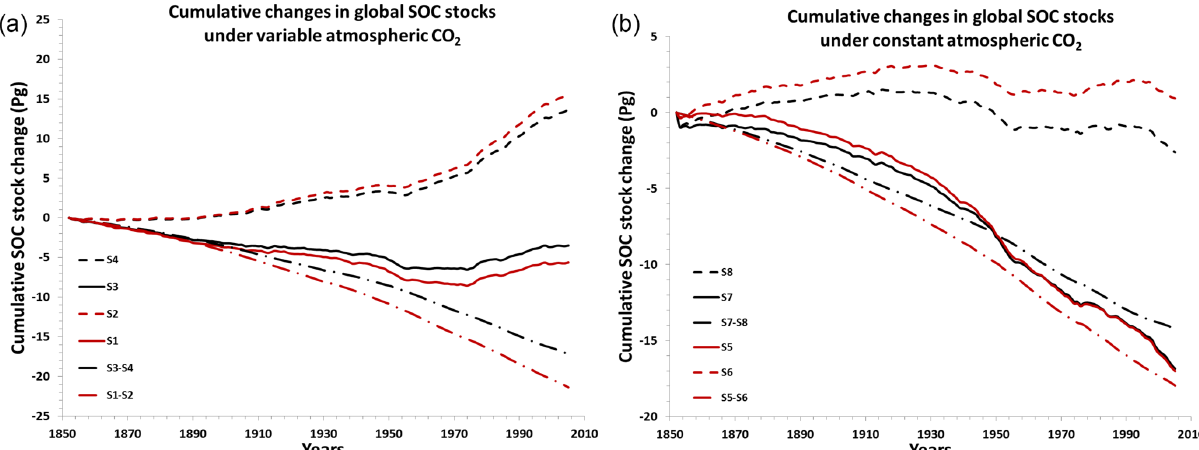
Figure 6. Cumulative SOC stock changes during 1850–2005 for (a) simulations with variable atmospheric CO 2 concentration and (b) for simulations with a constant CO 2 concentration, implied by variable land cover alone (dash–dotted lines), by variable climate (dashed lines), and variable land cover and climate (straight lines), without erosion (black lines) and with erosion (red lines).